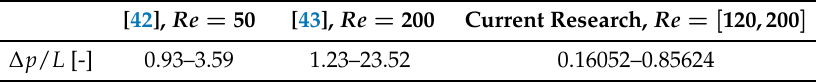
Table 3. Comparison of pressure losses with different mixing microchannels.